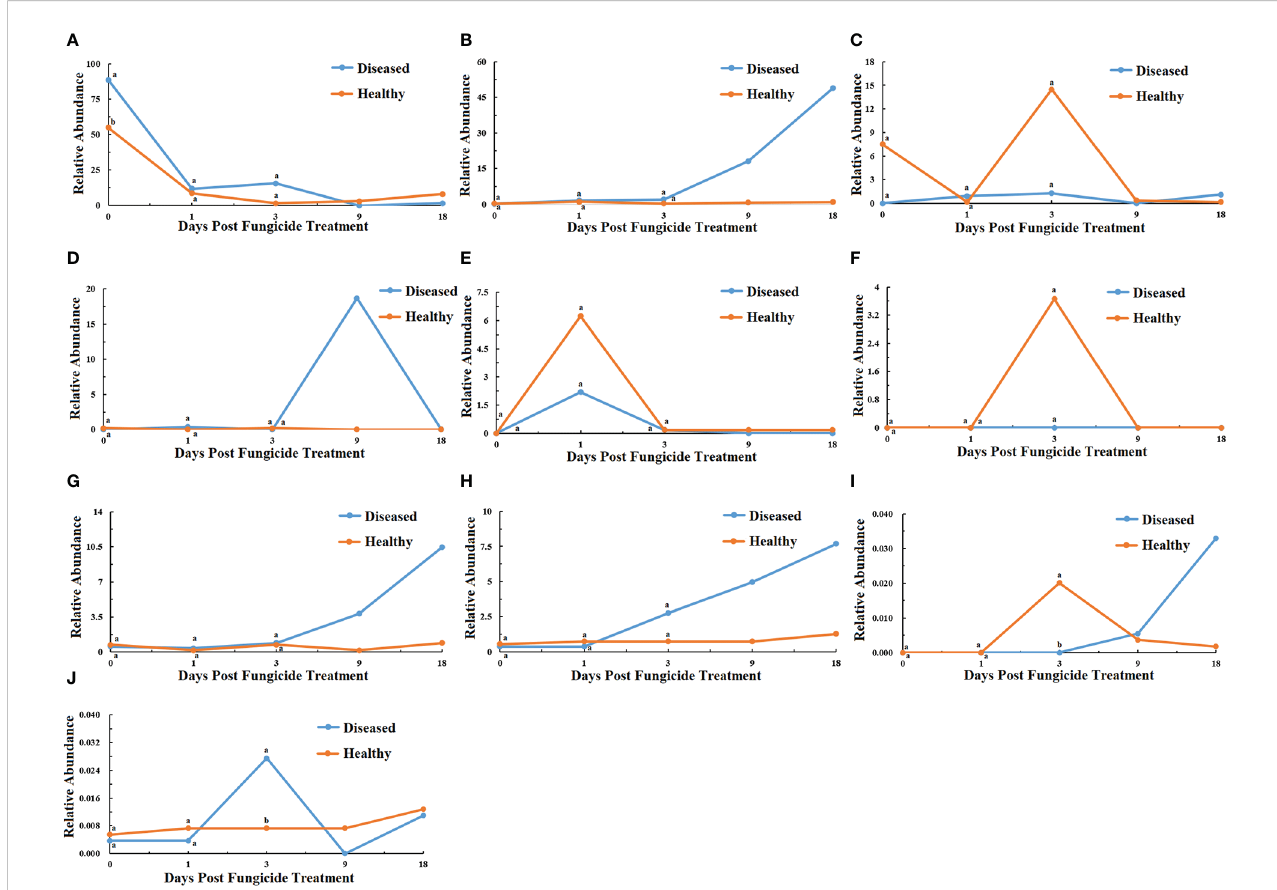
FIGURE 6 Changes in fungal community compositions at the genus level for diseased and healthy leaves over time after azoxystrobin treatment. (A) Thanatephorus, (B) Phoma, (C) Symmetrospora, (D) Pantospora, (E) Cercospora, (F) Gomphidius, (G) Plectosphaerella, (H) Cladosporium